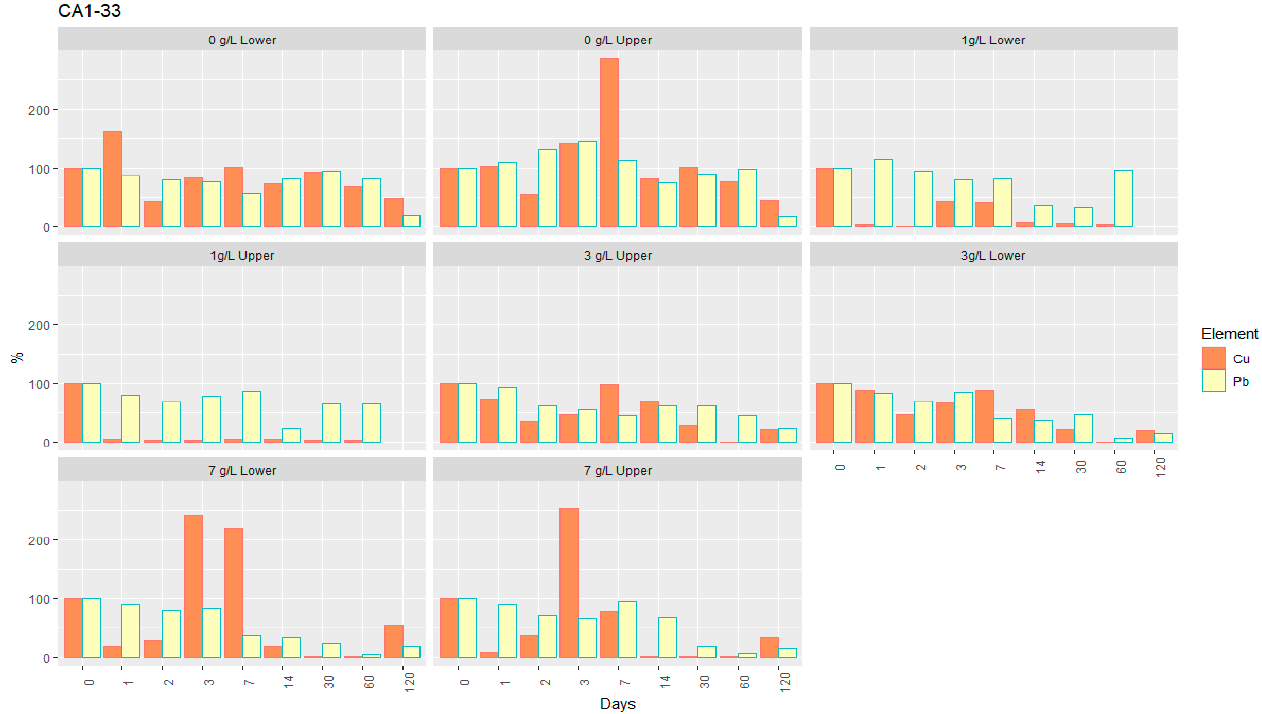
Figure 6. Changes in the Zn and Cd contents (%) in the soluble phase of samples, over 120 days of the remediation batch tests after the injection of nZVI suspension (concentrations of 0, 1, 3, and 7 g/L).